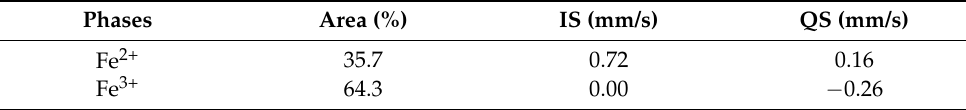
Figure 1. The structure and morphology of the precursor: ( a ) XRD pattern, ( b ) MES pattern measured at room temperature, ( c , d ) SEM images. Table 1. MES parameters of the precursor.